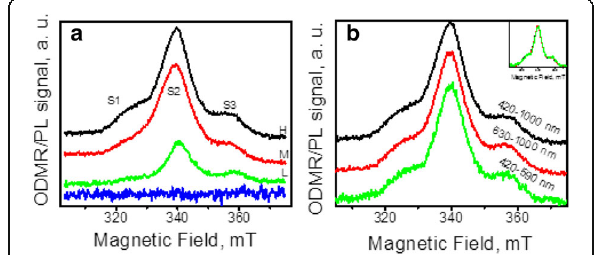
Fig. 3 ODMR spectra. a ODMR spectra of the L , M , H composites and pure PVA detected in the whole spectral range b and the ODMR response of the H composite in different spectral ranges